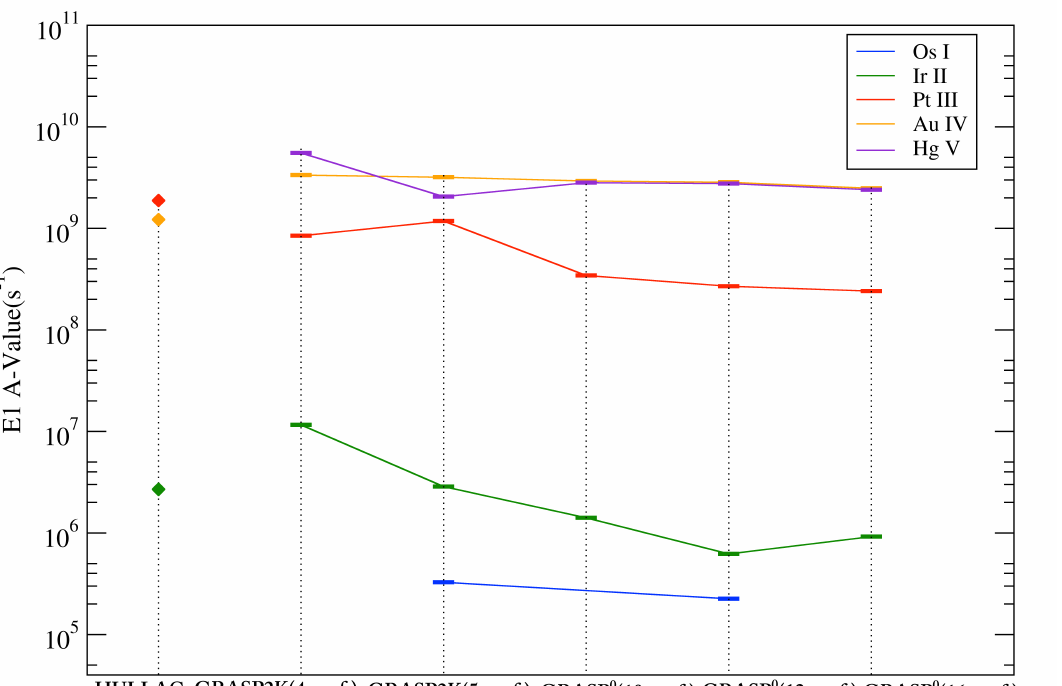
Figure 3. Convergence of E1 transition probability for different methods and numbers of configura- tions for the 5 d 8 3 F → 5 d 7 ( 2 H 3 ) 6 p 3 G